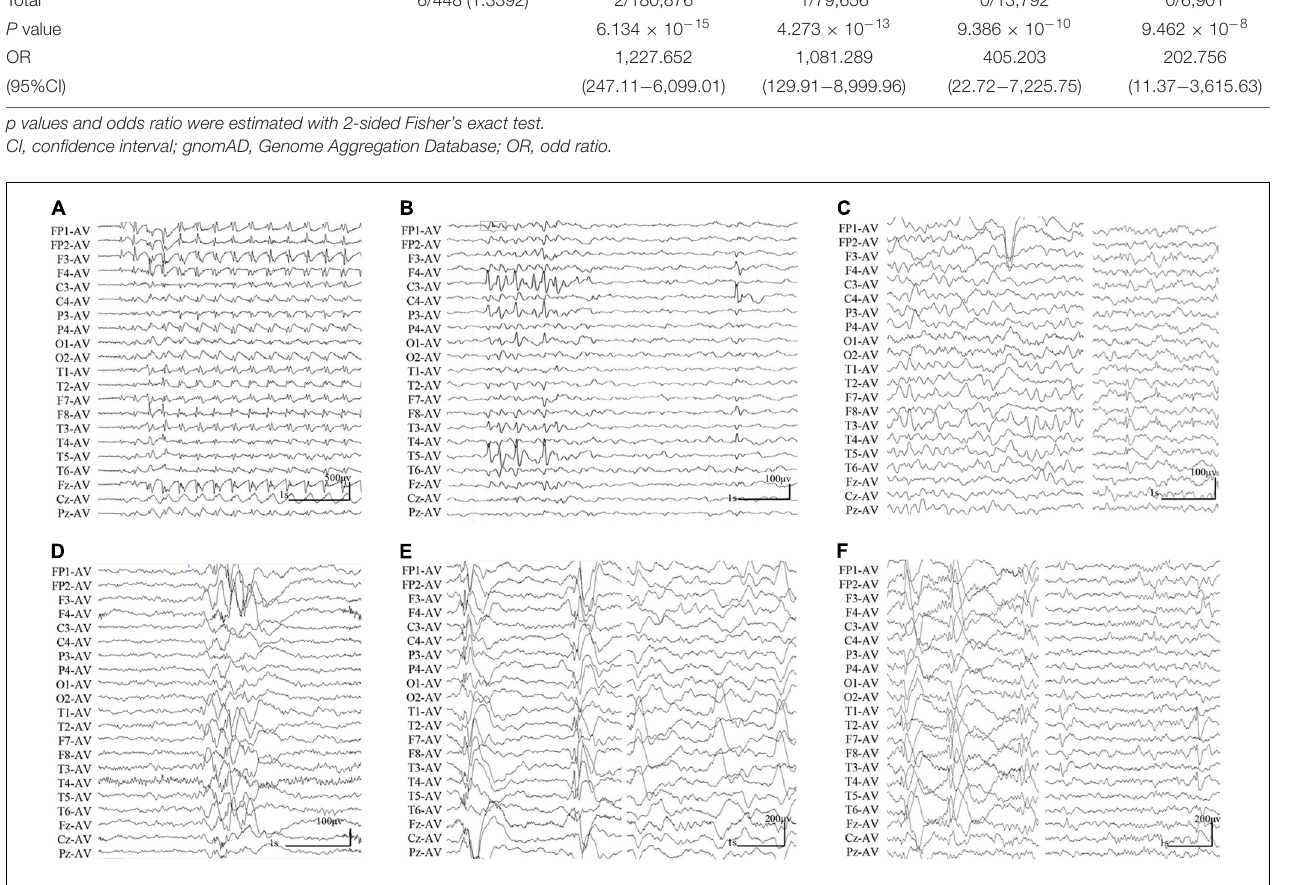
between SHROOM4 mutations and epilepsy remains